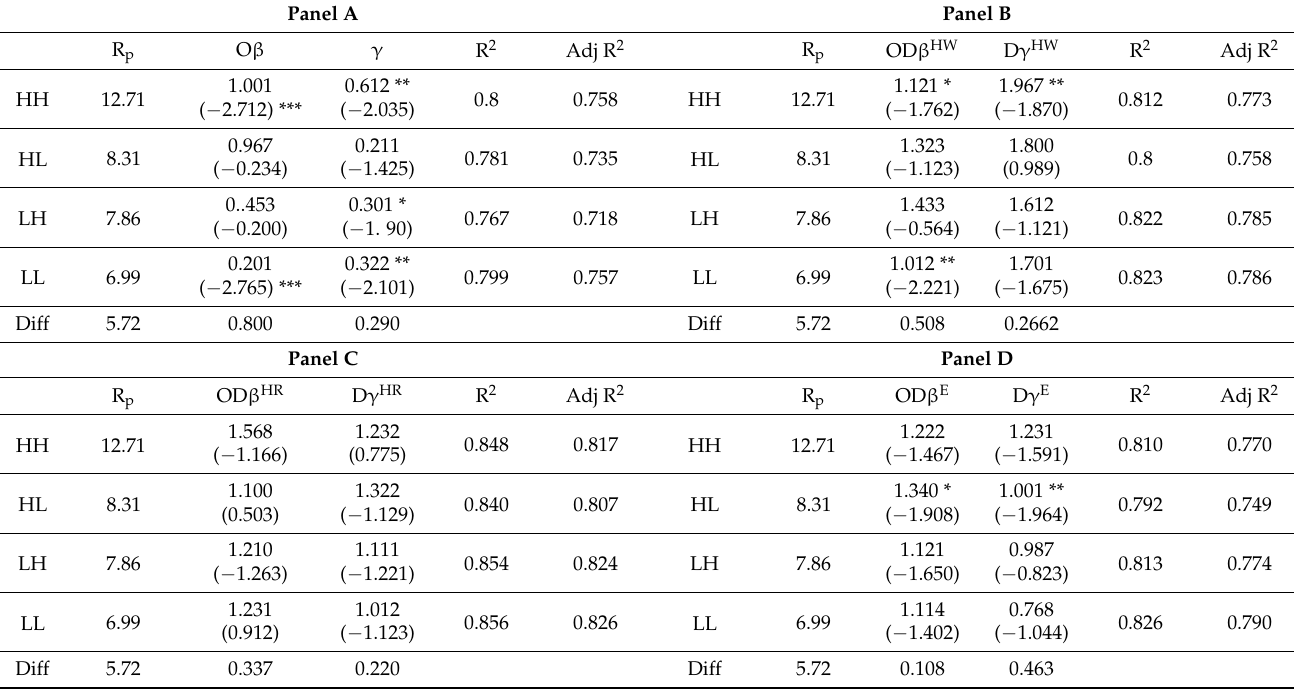
Table 4. Results for O β , OD β HW , OD β HR , and OD β E with γ , D γ HW , D γ HR , and D γ E , respectively, with R 2 and Adj R 2 and their t -stat in (). Diff is the difference of returns between HH and LL showing the risk–return relationship. Panel A Panel